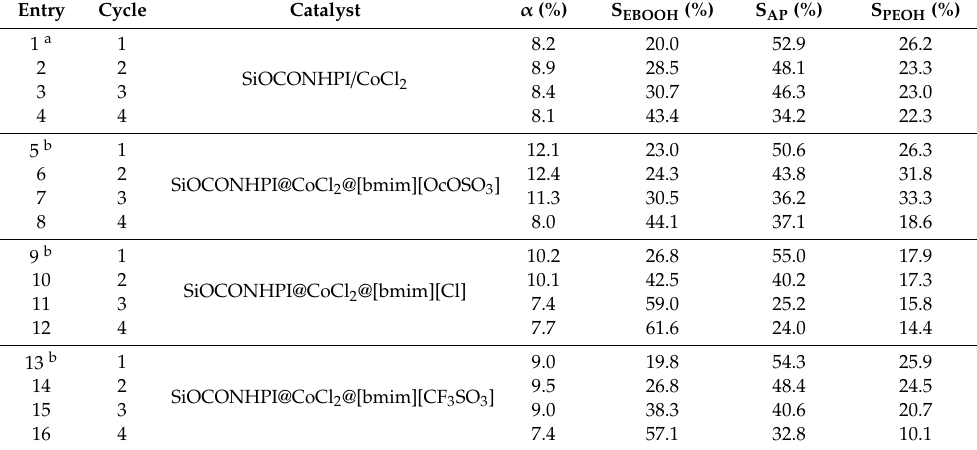
Table 3. Recovery and recycling of SiOCONHPI@CoCl 2 @[bmim][X] systems in ethylbenzene oxidation reaction.